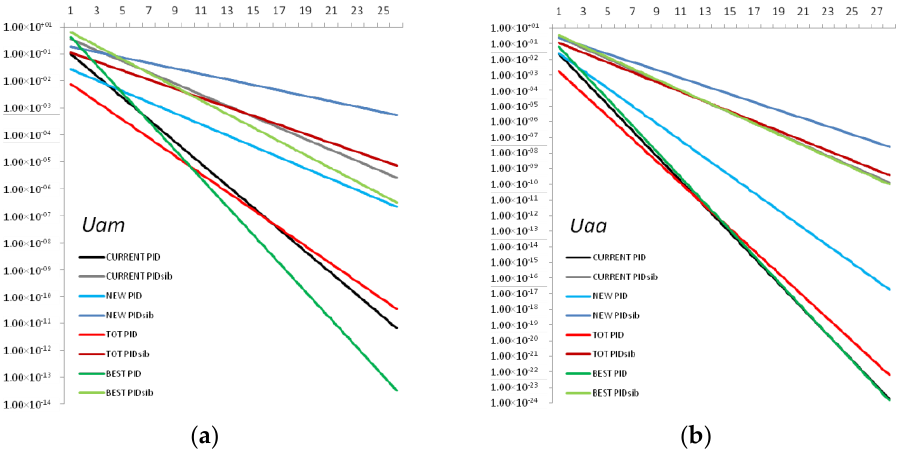
Figure 3. The theoretical predictions (trend lines) of the probability of identity for unrelated (PID) and related (PIDsib) individuals calculated for four different STR marker sets (CURRENT, NEW, TOT and BEST) for increasing locus combinations (the X-axis). Loci were combined from the most to the least informative for the ( a ) U. a. marsicanus ( Uam ) population; ( b ) U. a. arctos ( Uaa ) population.